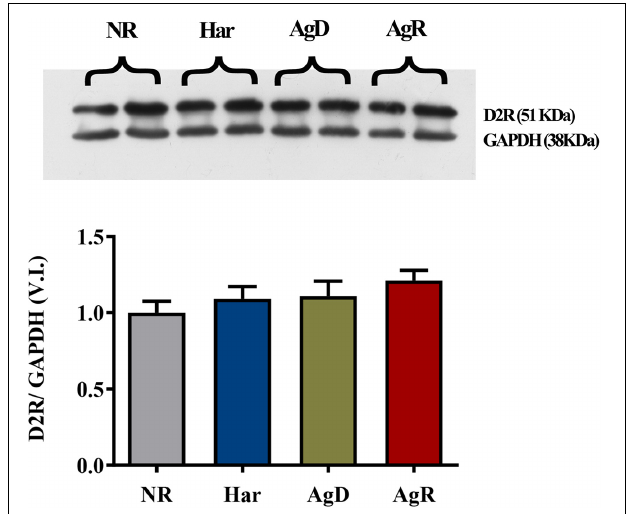
FIGURE 6 | Expression levels of the dopaminergic receptor 2. Quantitative analysis of D2 receptor expression by Western blot analysis according to the categories NR (gray bar), Har (blue bar), AgD (green bar) and AgR (red bar). GAPDH was used as an internal control for the samples. The values are expressed as the variation index (VI) of the mean ± standard deviation (SD) of the analyzed samples from three independent experiments using Kruskal-Wallis and Dunn’s test (NR; n = 9, Har; n = 10, AgD; n = 15; AgR; n = 10